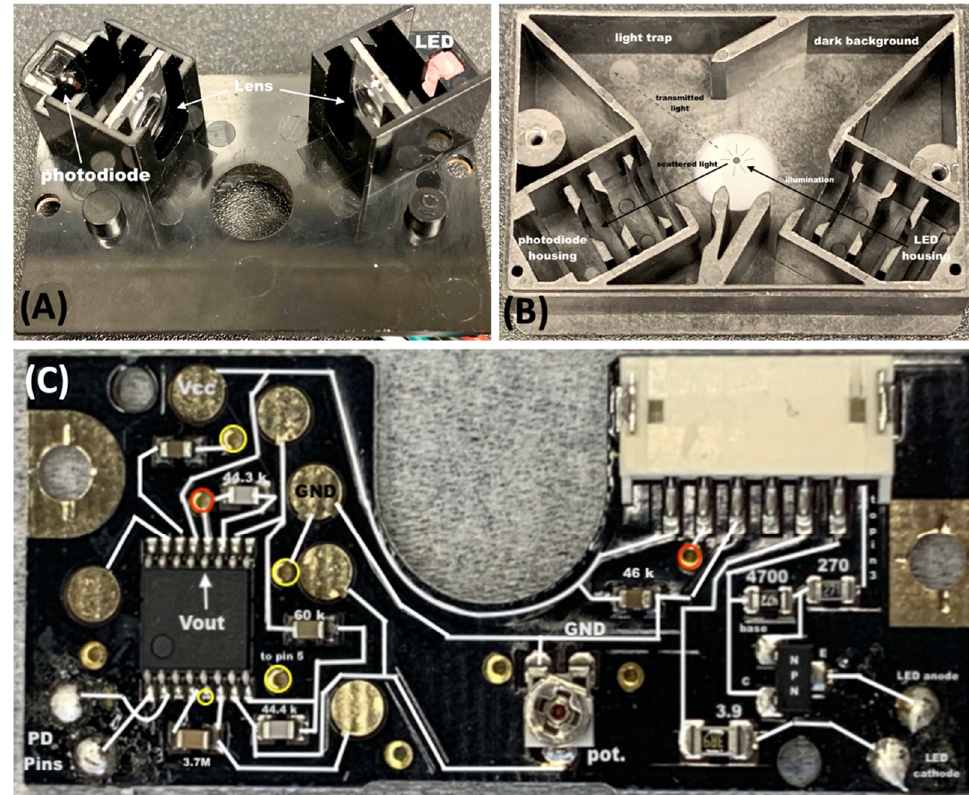
Figure 1. Sharp dust sensor optical layout ( A, B ) and circuit board ( C ). Resistances noted were measured using a multimeter, while all components were installed in the circuit, thus, these may not represent the true values. Small yellow and red circles denote common contacts/connections.